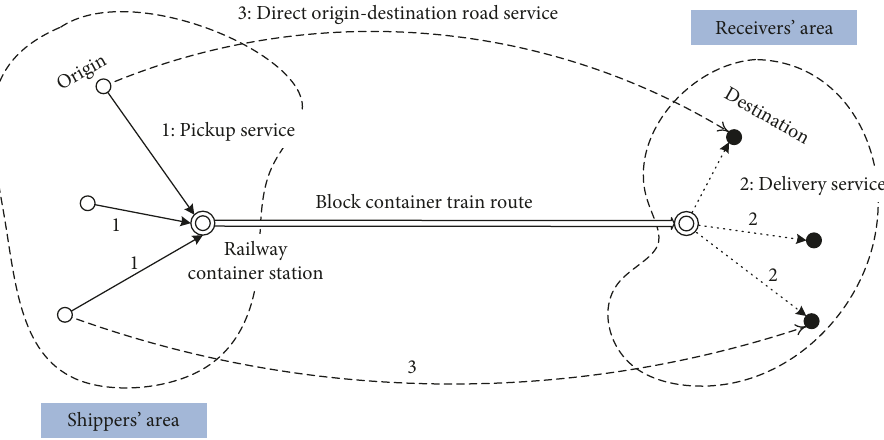
Figure 1: Basic topological structure of the multimodal service network.